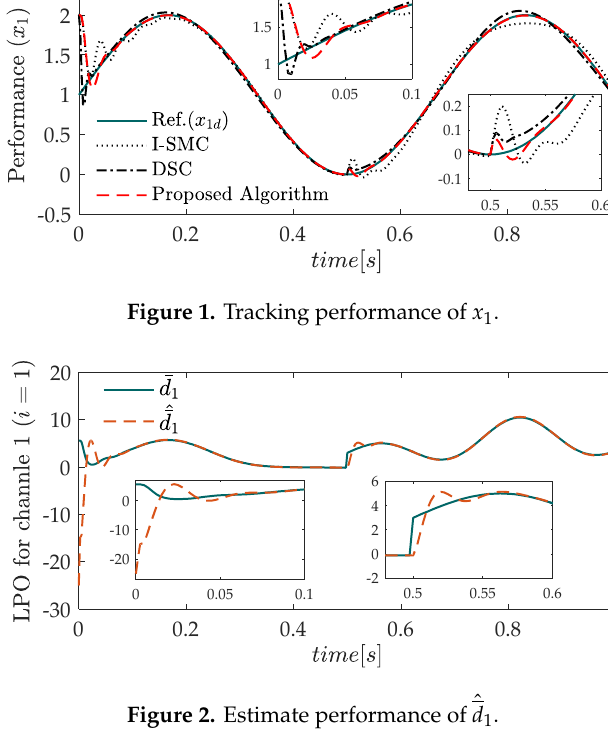
Figure 2. Estimate performance of 1